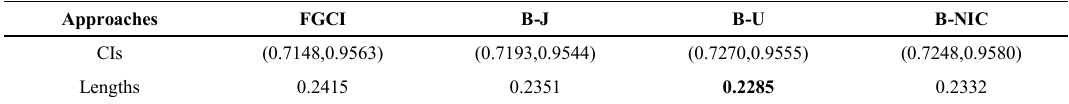
Table 3. The 95% confidence intervals and credible intervals for the CQV of the red cod data from the trawls survey in New